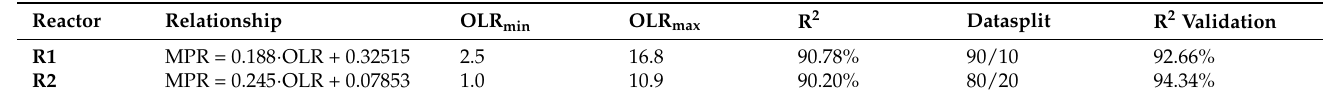
Table 5. Linear regression analysis data.